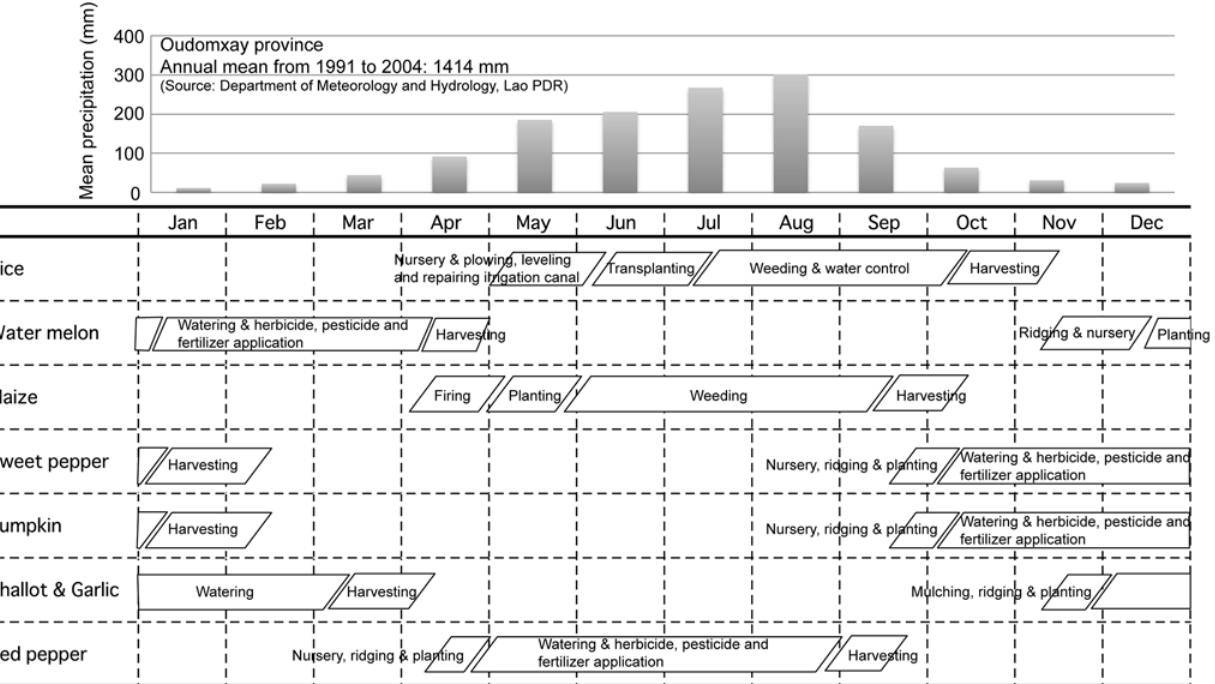
Fig 3. Seasonal patterns of rainfall (top) and major farming tasks (bottom), Na Savang village, northern Lao